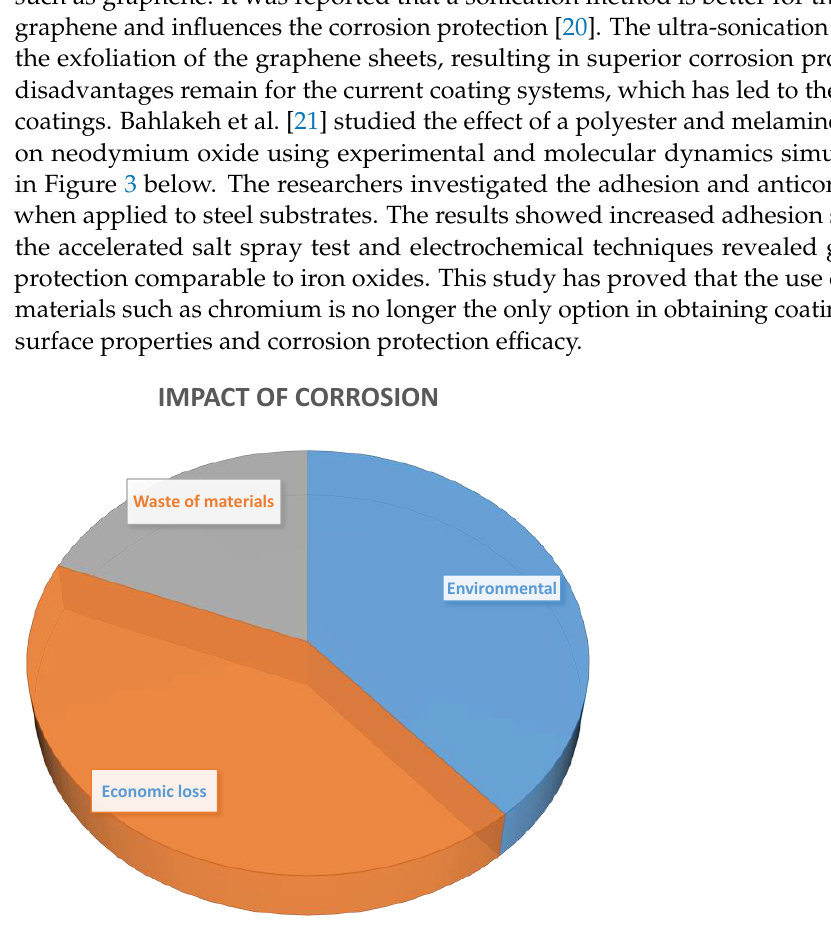
Figure 2 . The impact of corrosion. Figure 2. The impact of